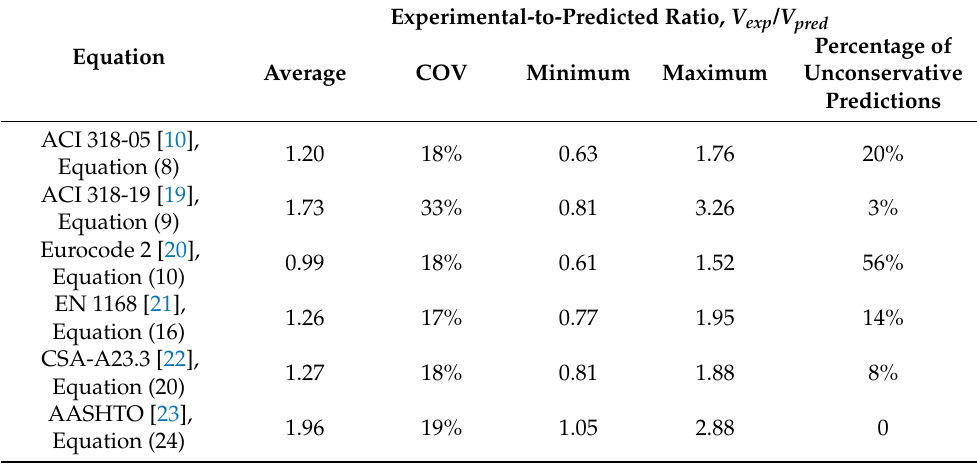
Table 2. Statistical analysis of design